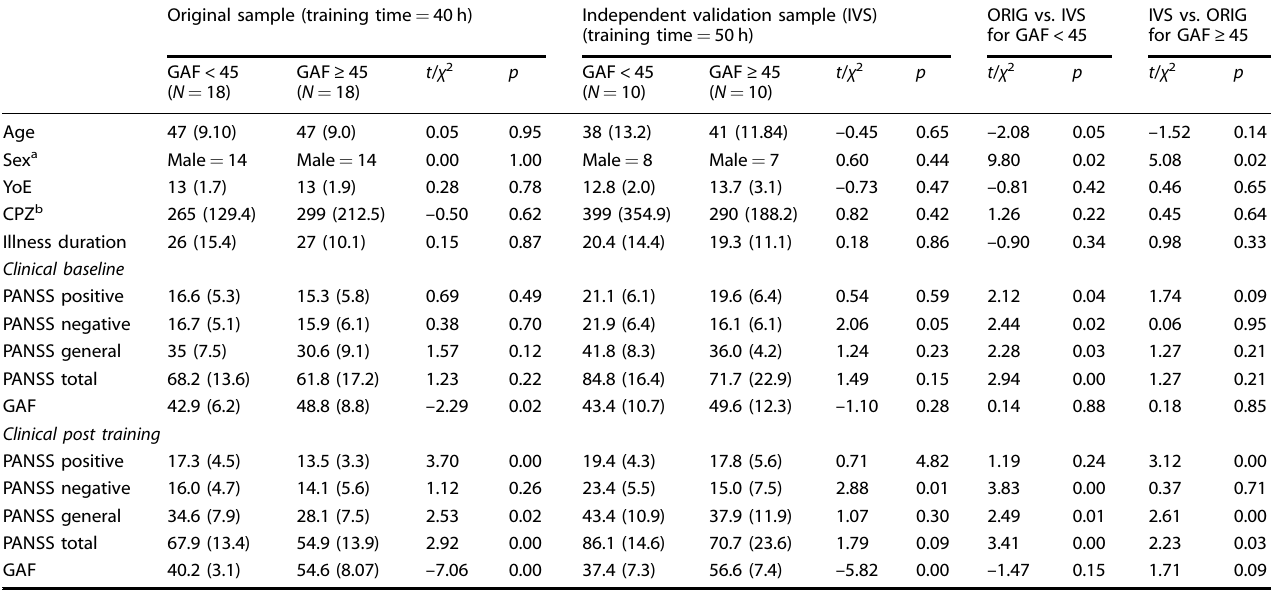
Table 1. Demographic and clinical characteristics at baseline for SCZ participants in the original sample and in the independent validation sample, separated by their GAF score median split at the post-training timepoint. Original sample (training time =